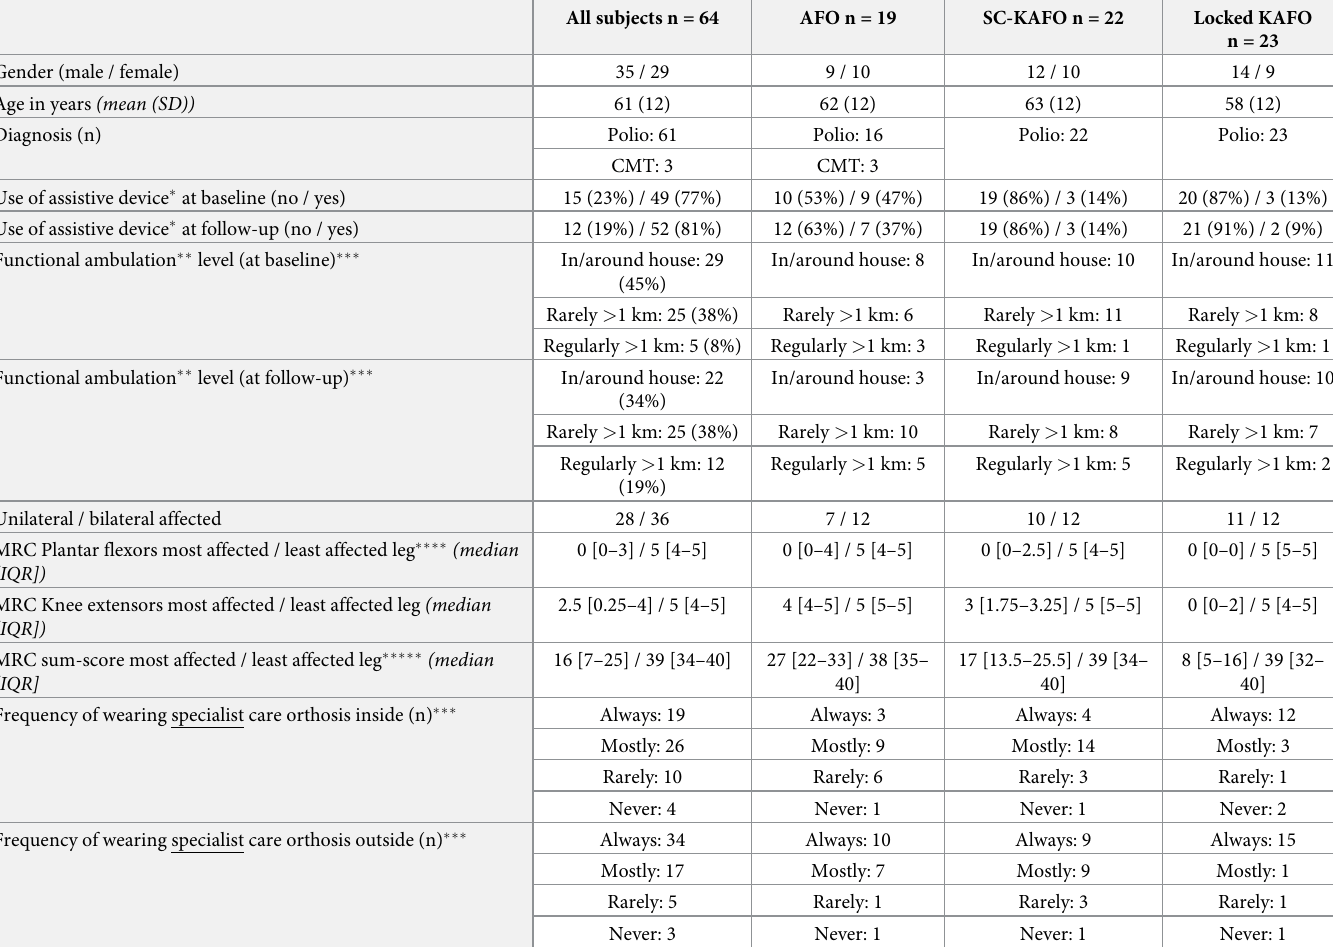
Table 1. Baseline demographics and clinical characteristics for all orthosis groups combined and for subgroups according to type of specialist care orthosis provided. All subjects n = 64 AFO n = 19 SC-KAFO n =